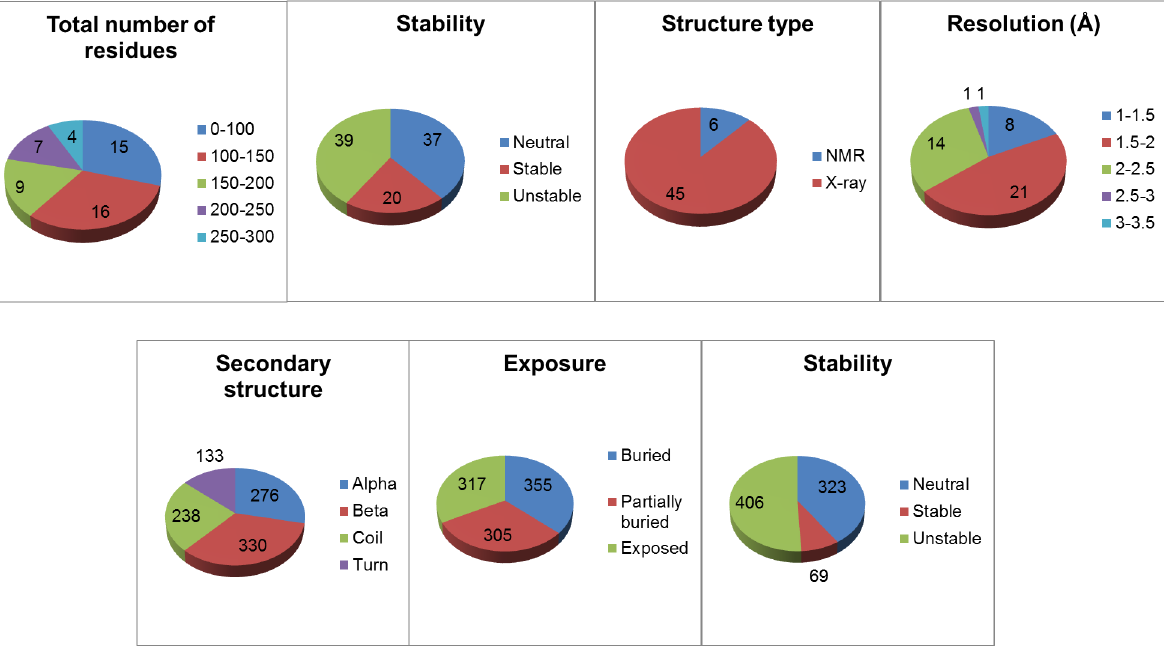
Fig 2. The diversity of protein structures (top 4 charts) and point mutation residues (bottom 3 charts) in the ddG data set. The sum of all proteins in the “ Stability ” pie chart is greater than the total number of proteins in Table 1, because some proteins have multiple mutations in different stability categories i.e. stable, neutral, or unstable. The “ Resolution ” chart only has data from proteins which have crystal structures. An NMR structure doesn ’ t have a resolution.